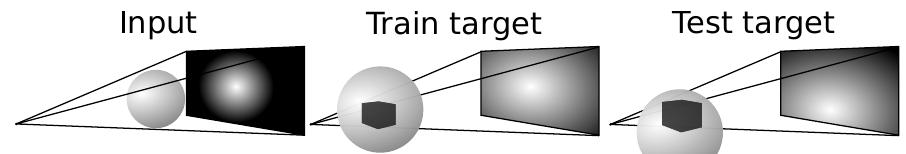
Figure 5. For each object, three projection datasets are acquired. The first dataset has the entire object in the field of view, and its reconstruction is used as input data for the learning step. The second dataset has a central region of interest in view (dark gray), the reconstruction of which is used as target data for the learning step. The third dataset has an upper region of interest in view (dark gray), the reconstruction of which is used as target data for